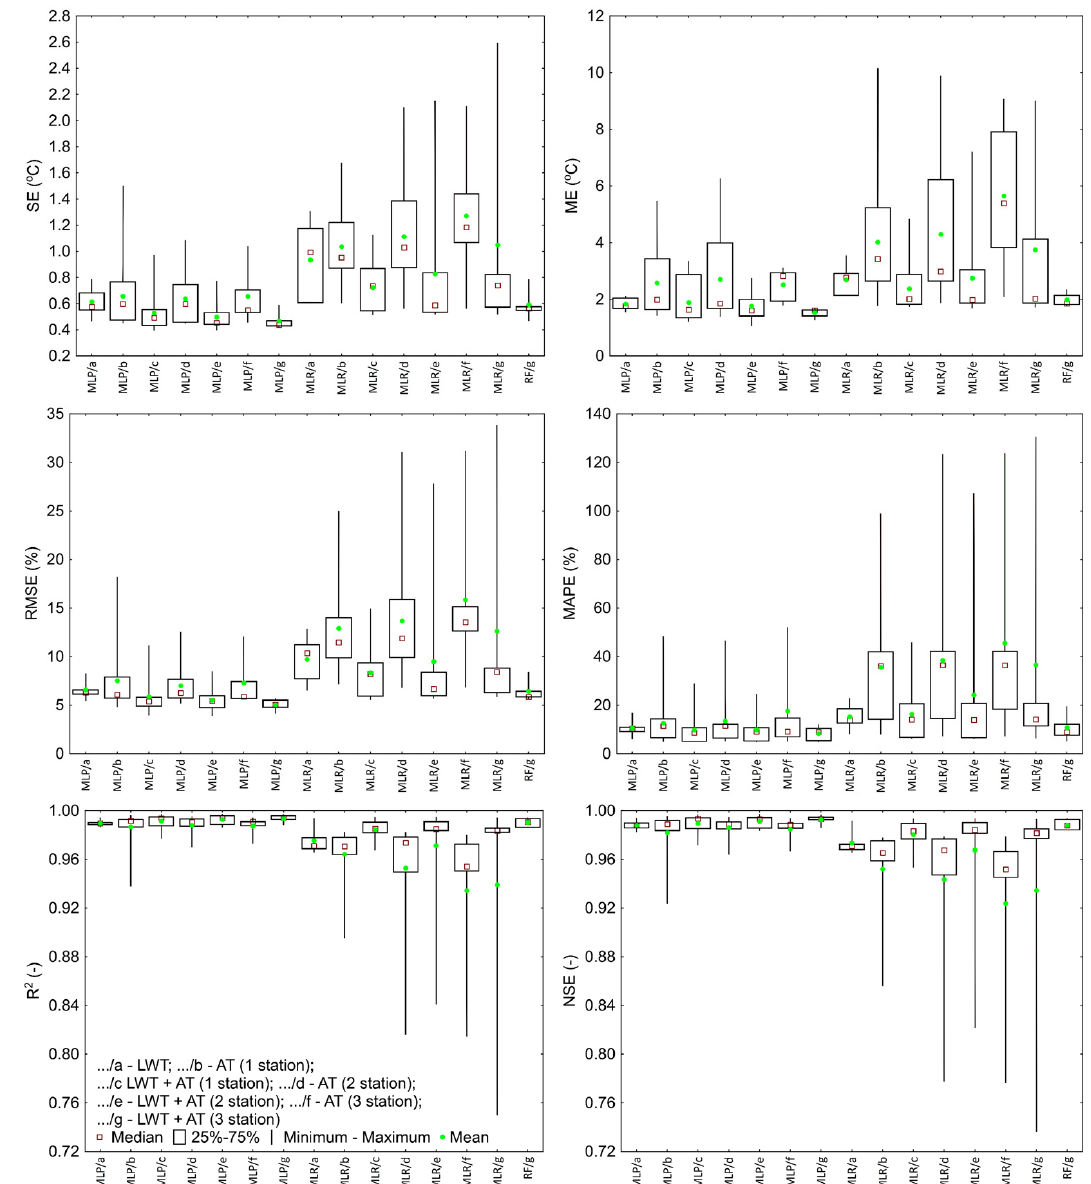
Figure 4. The results of the validation of the reconstruction of water temperatures in rivers are based on a variable range of output data and the statistical methods multilayer perceptrone network, multiple linear regression, and random forest regression.